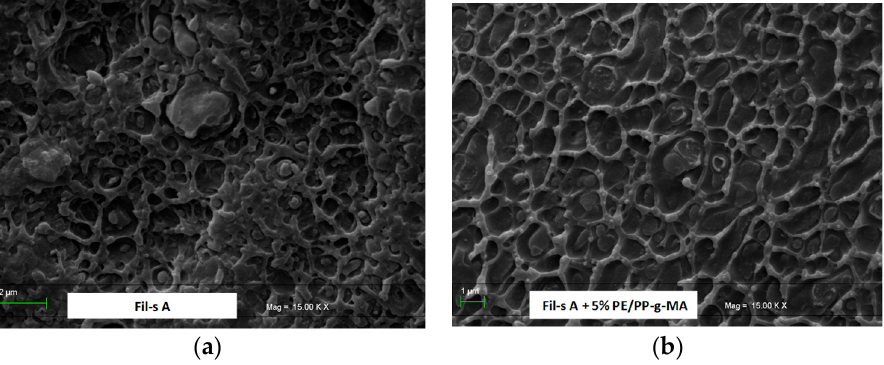
Figure 5. SEM images of ( a ) Fil-s A as such and ( b ) after the addition of PE/PP-g-MA compatibilizer. Moreover, the presence of the PE/PP-g-MA additive strongly influences the viscoelastic behavior of both Fil-s systems filled with the nanosilicate (Figure 4), with significant increments of the dynamic viscosity η ’ and the storage modulus G’ values compared with the pristine recycled materials. In particular, higher values of these viscoelastic properties and stronger incremental increases with respect to the neat matrix can be observed for the Fil-A-based system, suggesting a better polymer-silicate interaction. This latter outcome can be correlated to the finer distribution of the PE/PP-g-MA additive inside Fil-s A with respect to Fil-s B due to its higher polar character, as demonstrated in the previous paragraph. In turn, this affects the filler dispersion degree, as also evidenced by TEM micrographs of Fil-s A-based composites in Figure 6a,b.